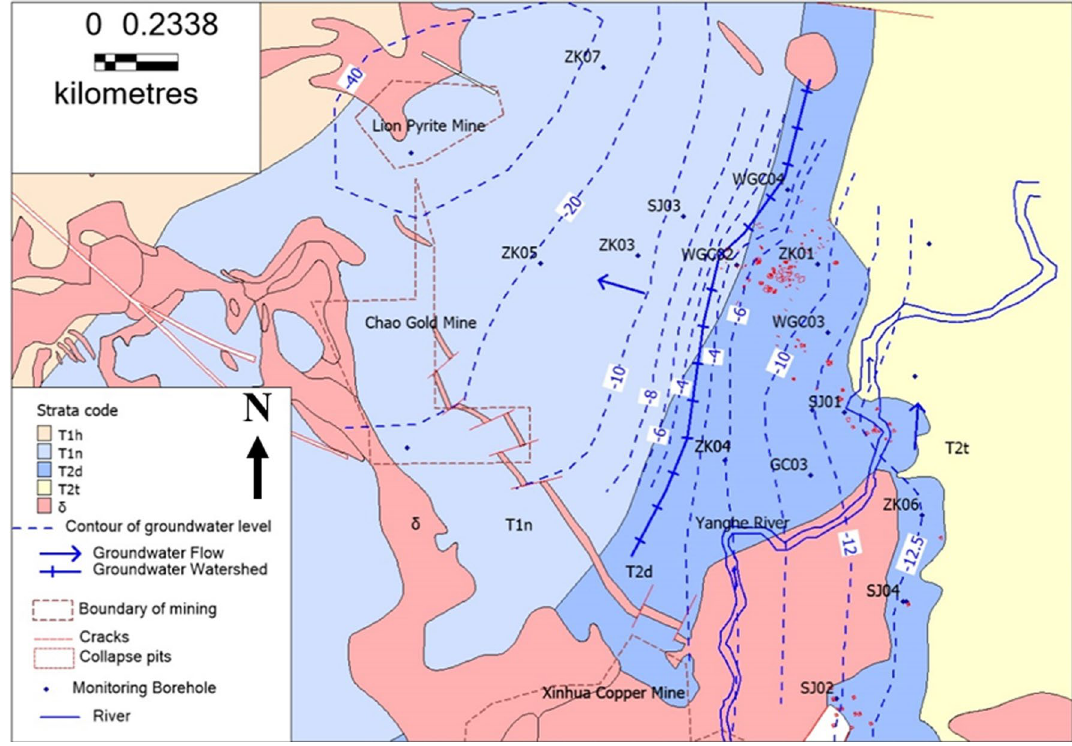
Fig. 5 Contours of groundwater level in the study area (see Table 1 for legend of